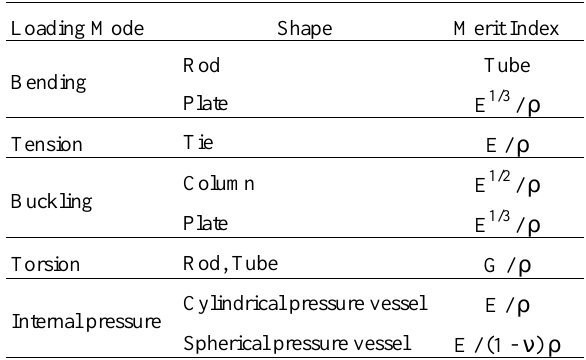
Table 1. Merit indices for different loading modes when stiffness is the main project